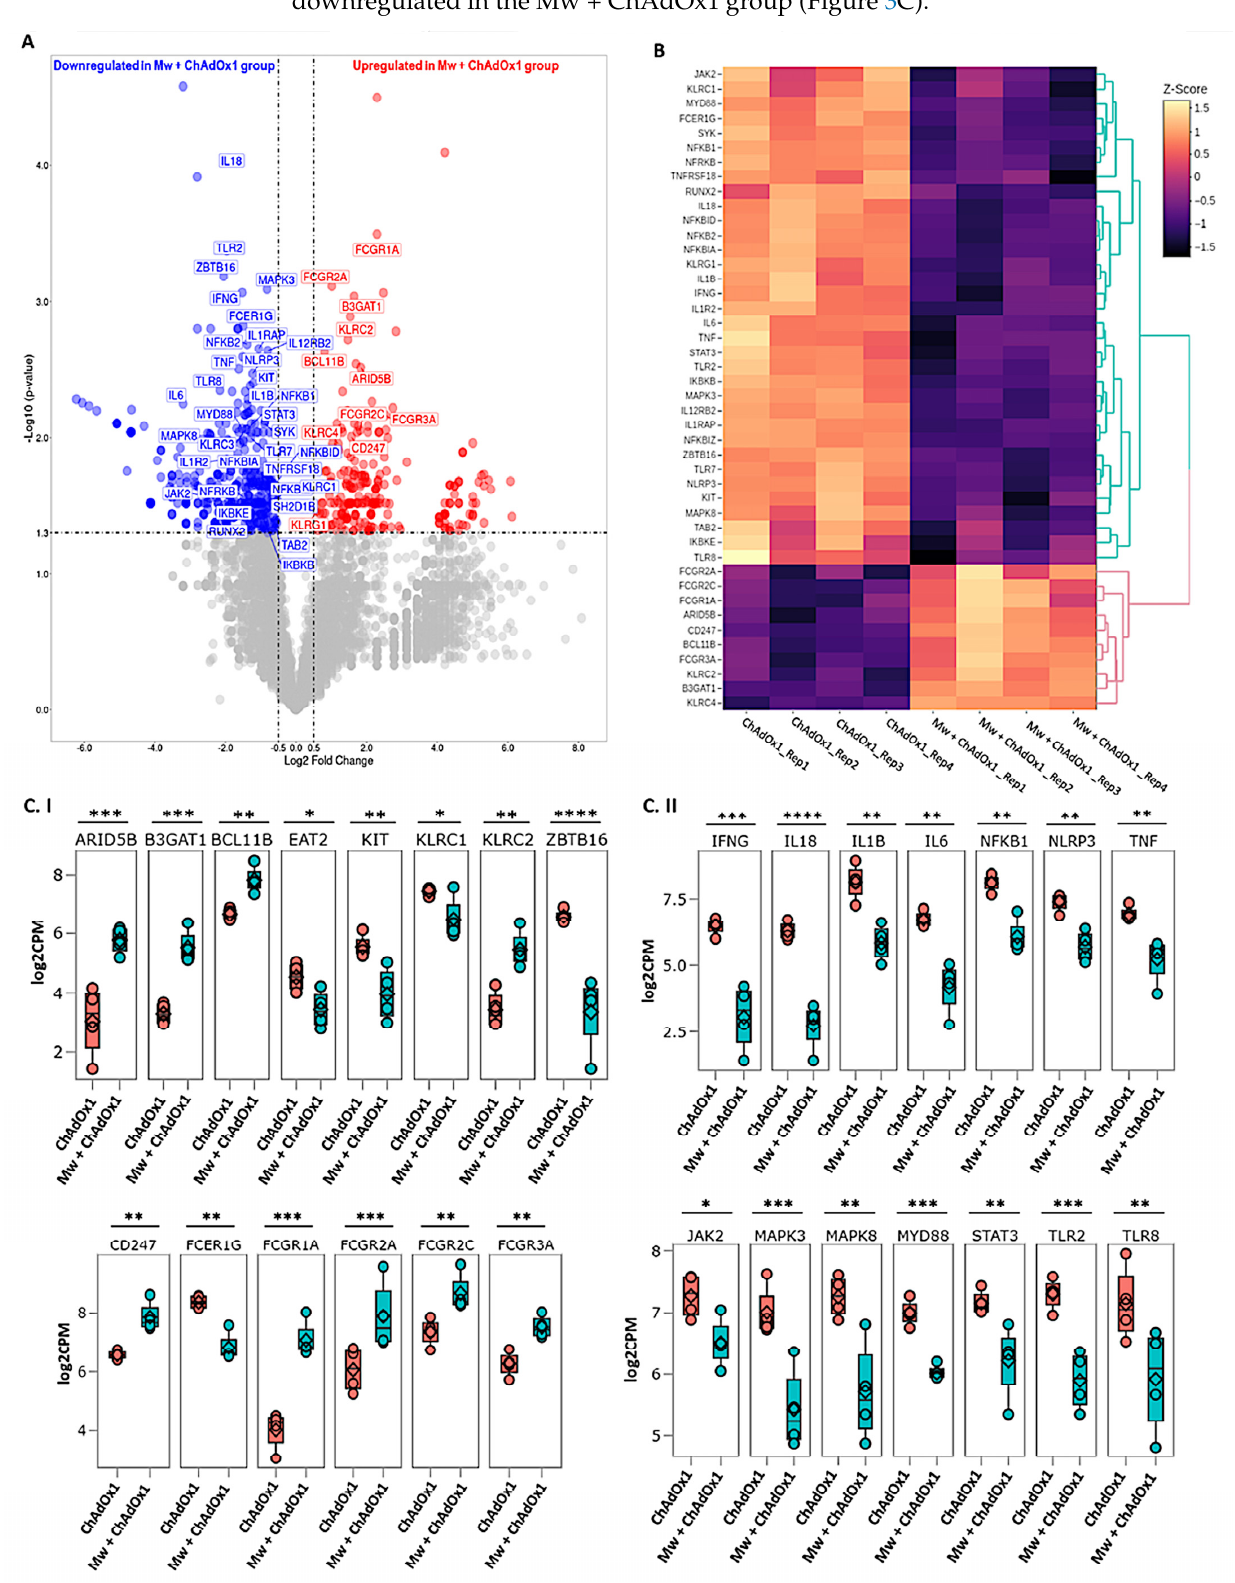
Figure 3. Differential gene expression analysis in Mw + ChAdOx1 and ChAdOx1 group. ( A ) Volcano plot showing genes differentially expressed in Mw + ChAdOx1 compared to ChAdOx1 group.